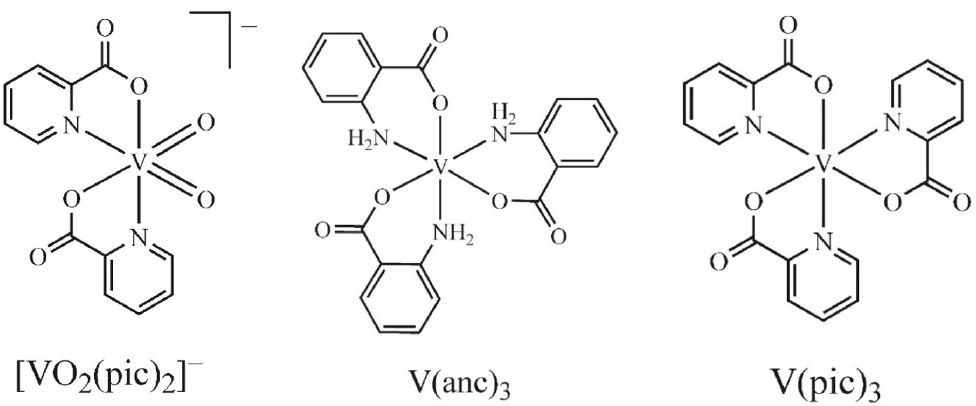
Figure 2. Structures of vanadium complexes found to substantially inhibit CNPase activity in this study.